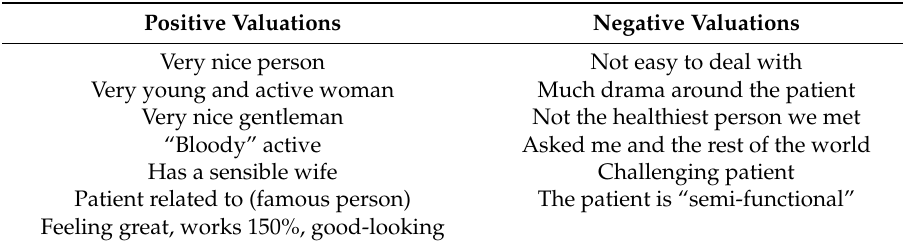
Table 2. Examples of positive and negative valuations.